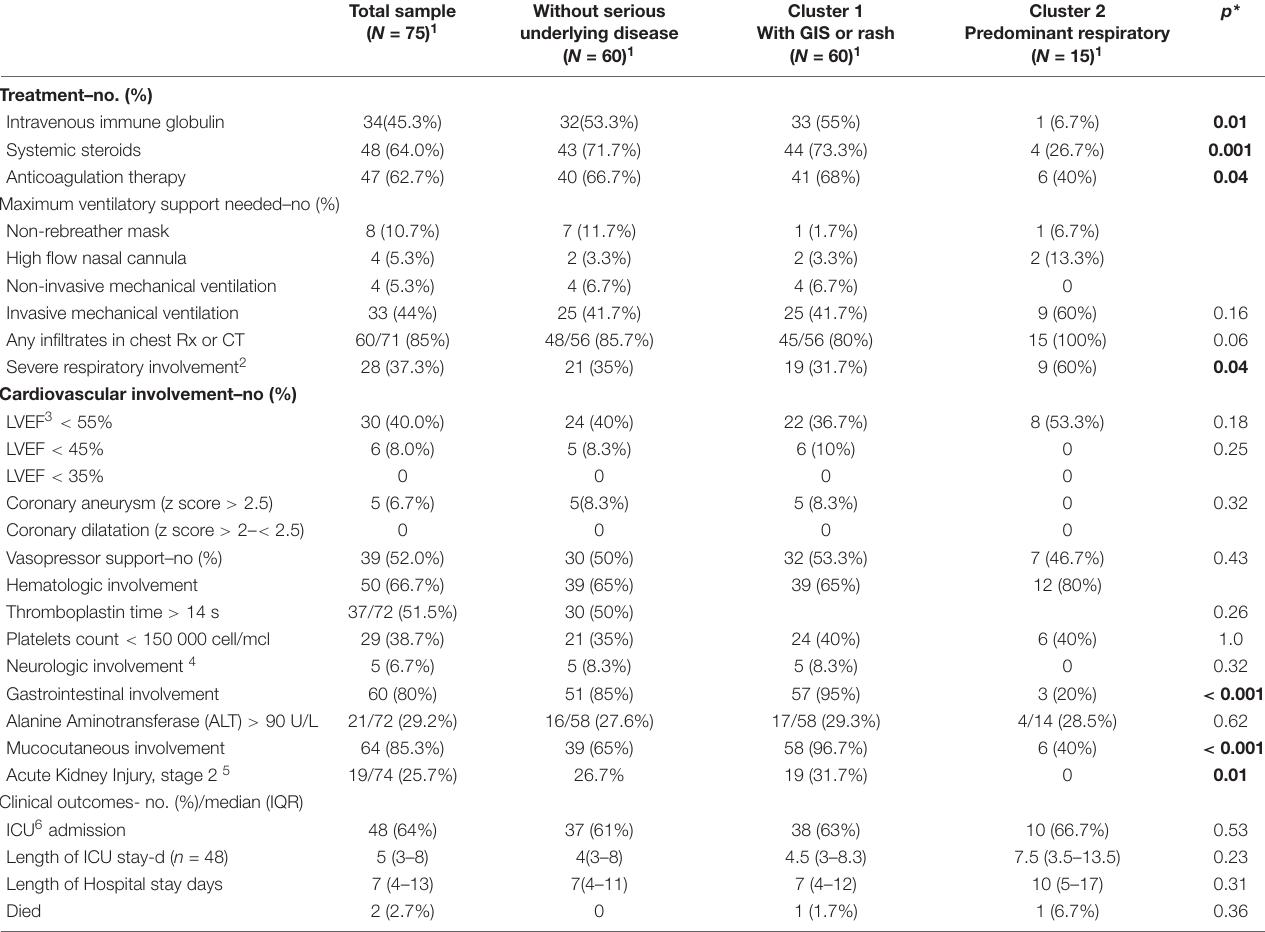
TABLE 3 | Treatment and outcomes of cases with